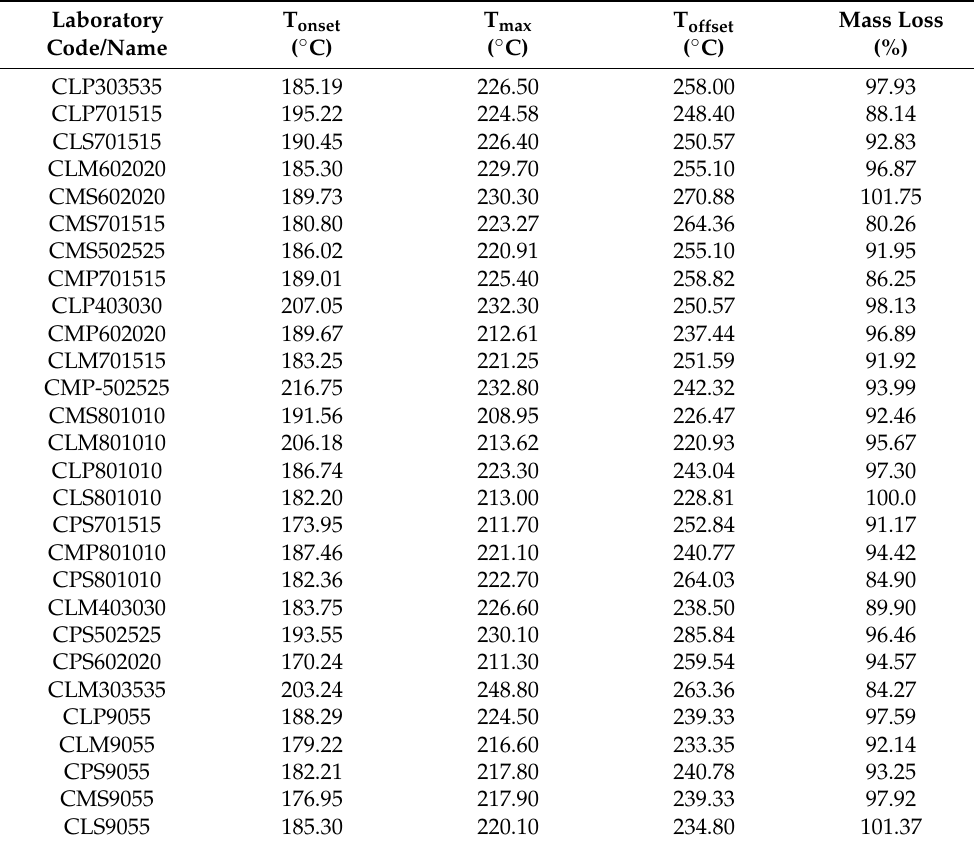
Table 13. TGA result of the different developed